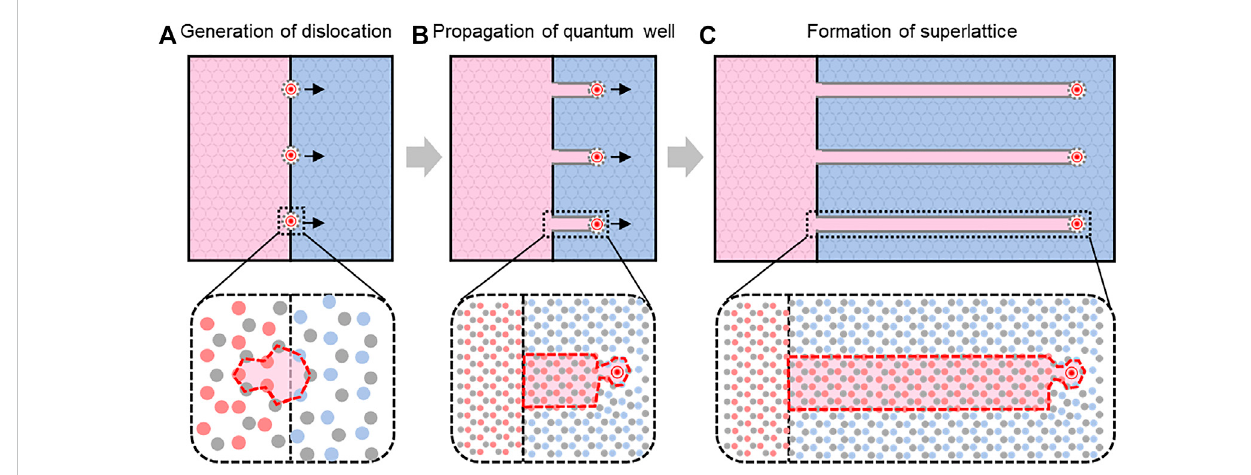
FIGURE 4 Diagrammatic sketch of the formation mechanism of WS 2 quantum wells at the interface between WSe 2 and WS 2 . (A) Generation of dislocation. (B) Propagation of quantum wells. (C) Formation of the WS 2 superlattice.